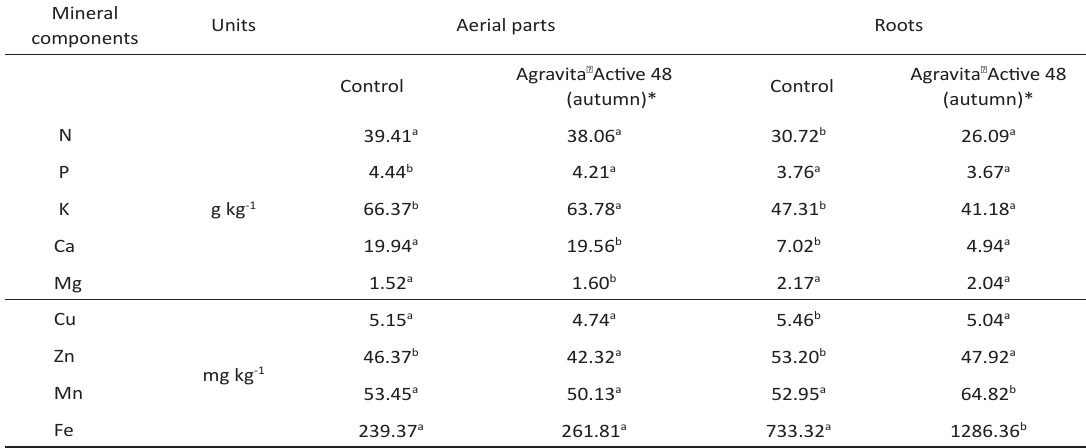
Table 4. Macro- and micronutrient content in winter oilseed rape (BBCH 20) Mineral Units Aerial parts Roots components Agravita  Active 48 Agravita  Active Control Control (autumn)*